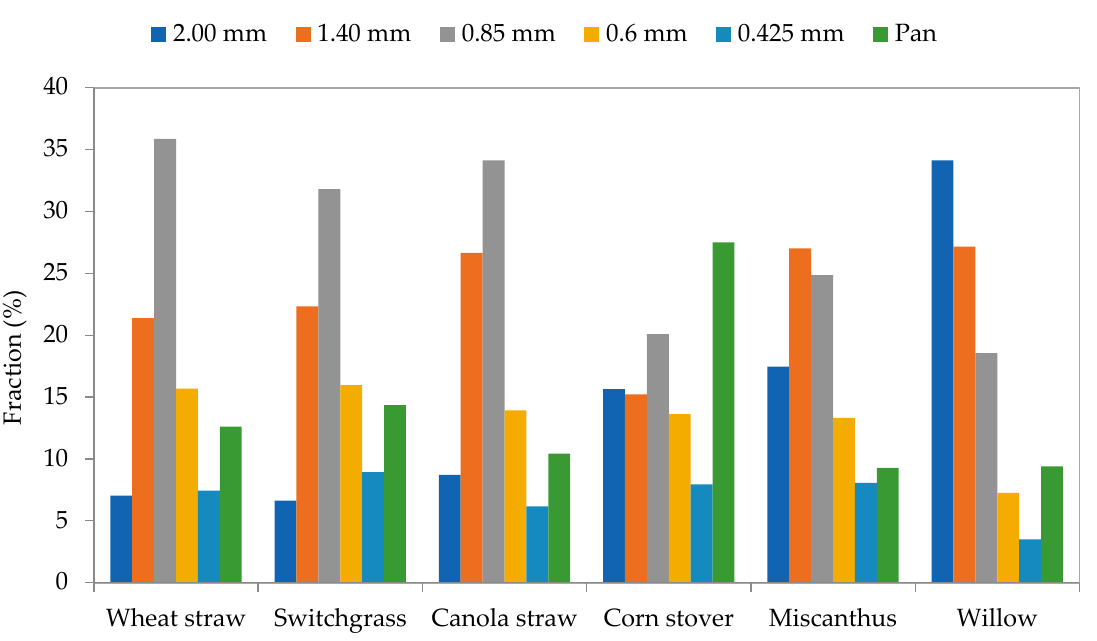
Figure 3. Particle size distribution for crop straw/forage and tree branches after grinding using a 6.4 mm (1/4”) screen in a hammer mill [48].